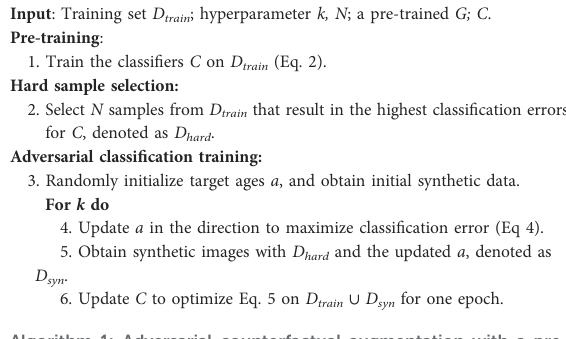
Algorithm 1: Adversarial counterfactual augmentation with a pre- trained G